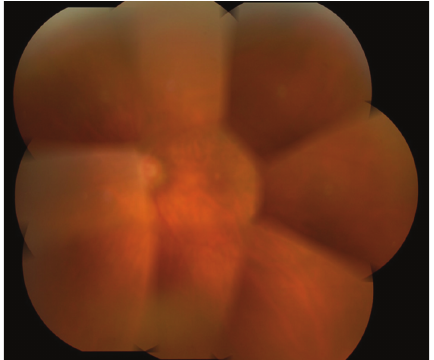
Figure 3: Panorama photograph of the fundus in the left eye at the 2nd week after the beginning of valganciclovir. Since hypopyon and vitreous opacity had disappeared, the fundus of the left eye could be observed enough. No inflammation sign could be observed at the